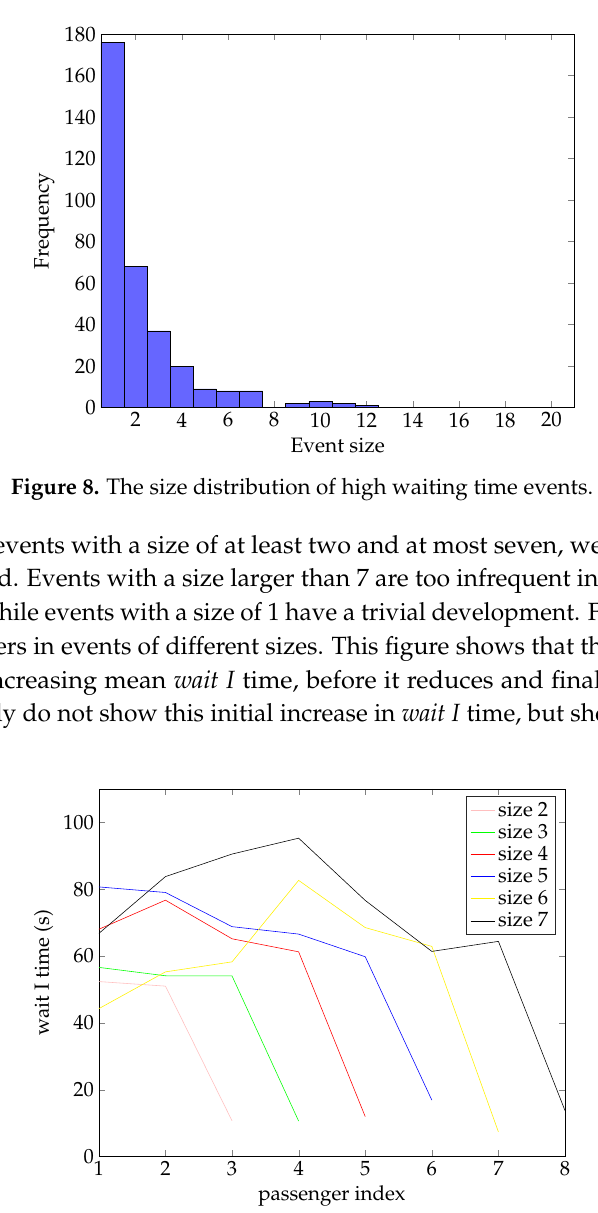
Figure 9. The mean wait I time for passengers involved in a waiting time event of a specific size. A passenger at index i is the i th passenger affected by the